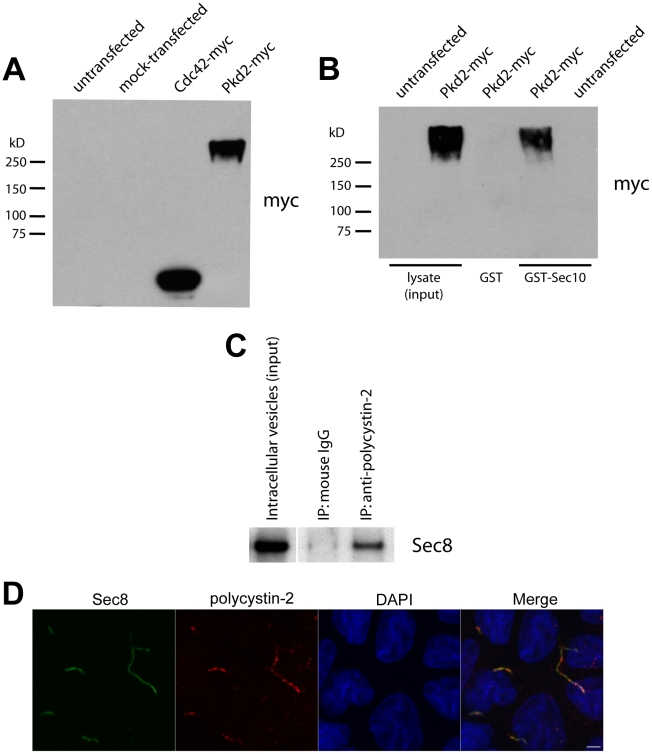
Sec10 biochemically interacts with polycystin-2.(A) Human PKD2-myc in pcDNA3 was transfected using lipofectamine into
HEK293 cells. Western blot was performed on the lysate (labeled
“Pkd2-myc”), using antibody against the myc epitope tag.
Polycystin-2-myc is seen, but at a higher molecular weight than
expected, suggesting that the polycystin-2-myc is in a polymeric form.
Identical results were seen using a monoclonal antibody against
polycystin-2 (data not shown).
“Cdc42-myc” = lysate from MDCK cells
expressing Cdc42-myc (a positive control for the Western blot). (B)
Purified Sec10-GST, but not GST alone, pulled down polycystin-2-myc from
PKD2-myc transfected HEK293 cell lysate. (C) Exocyst Sec8
co-immunoprecipitated with polycystin-2, but not the isotype control,
from intracellular vesicles isolated from mouse kidney lysate. The lanes
in (C) were all from the same gel, though the intracellular vesicle
input lane was separated from the other lanes (denoted by a white line).
(D) Immunofluorescence staining, using a monoclonal antibody against
exocyst Sec8 (green) and a polyclonal antibody against polycystin-2
(red), demonstrated co-localization of endogenous exocyst and
polycystin-2 at the primary cilium (yellow in the merged panel) in MDCK
cells grown on a Transwell filter for ten days. The panel showing
DAPI-stained cell nuclei (blue) was taken at a different level inside
the cell than the panels for Sec8 and polycystin-2, and is included here
to delineate individual cells. Bar = 1 μm.